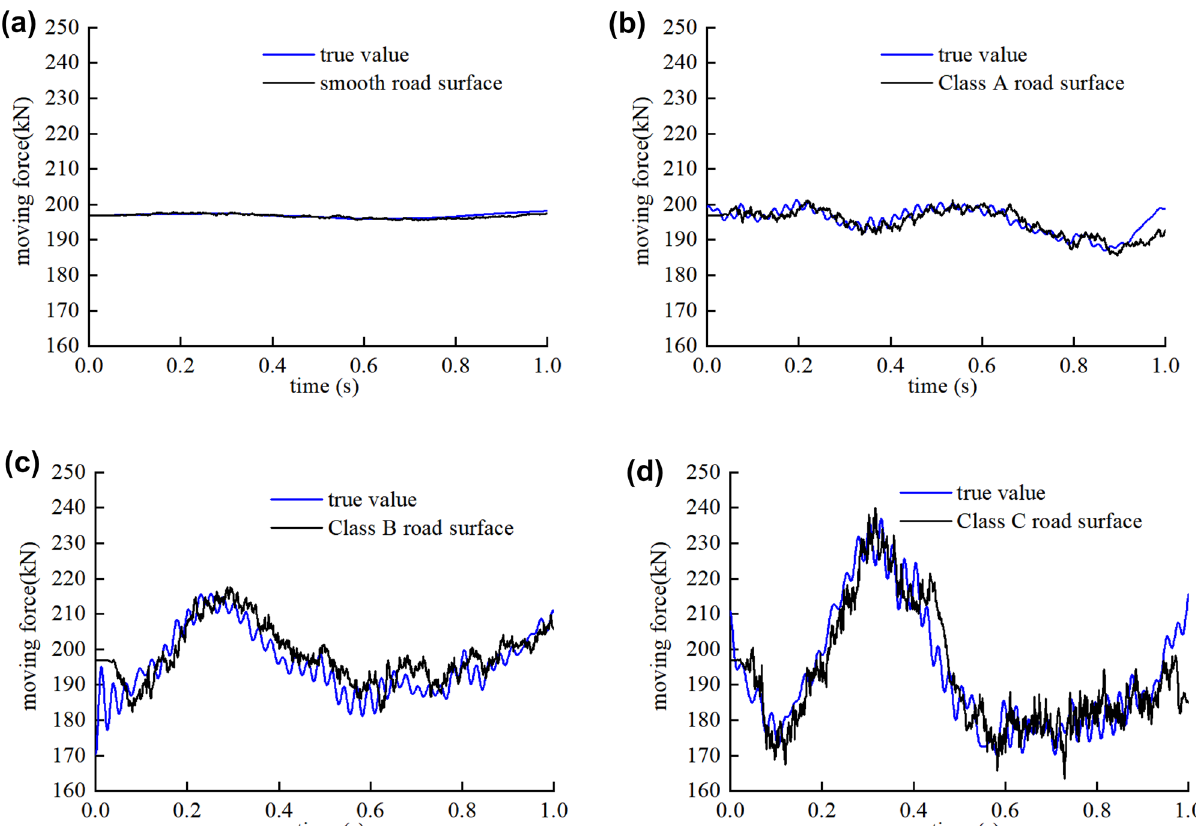
Figure 9. Identification results of moving force on different classes of road surface on ( a ) smooth road surface, ( b ) Class A road surface, ( c ) Class B road surface and ( d ) Class C road